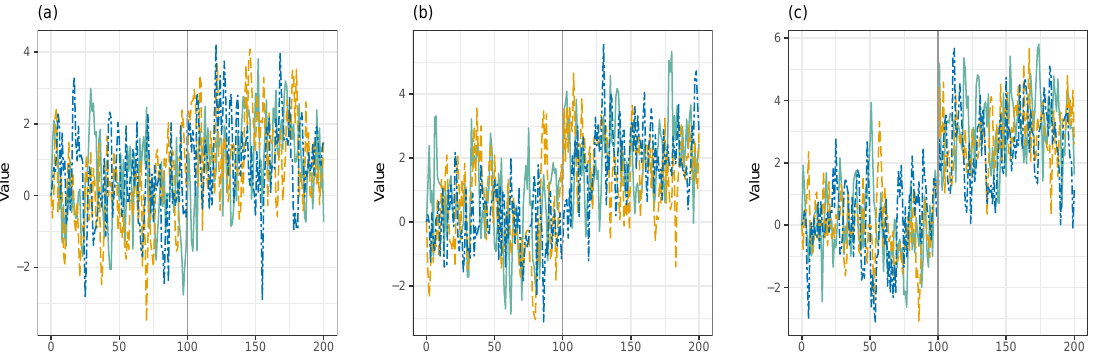
Figure 2. ( a ) The three samples of the simulated AR(1) process whose mean varies from δ 1 = 0 to δ 2 = 1. ( b ) The sample with a shift from δ 1 = 0 to δ 2 = 2. ( c ) The simulated sample from δ 1 = 0 to δ 2 =